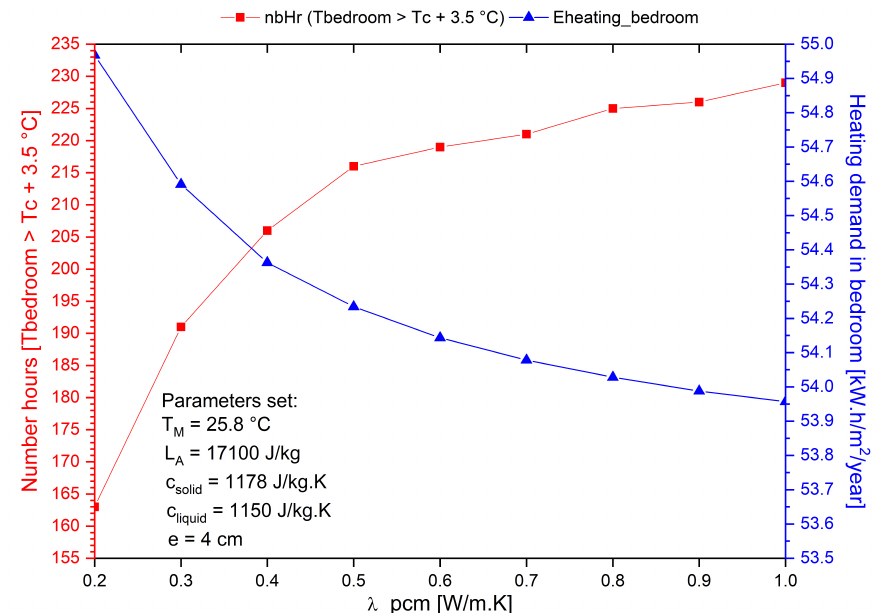
Figure 15. Number of hours of thermal discomfort and heating demand vs. thermal conductivity during the cold season (7 months total: January–April and